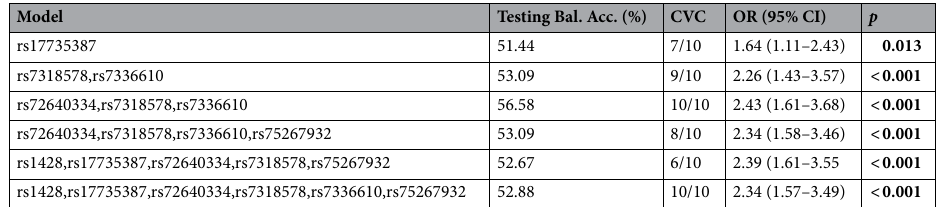
Table 5. SNP–SNP interaction models of MIR17HG gene the predisposition of HAPE. MDR multifactor dimensionality reduction, Bal. Acc. balanced accuracy, CVC cross-validation consistency. p values were calculated using χ 2 test. Bold indicated that p < 0.05 means the data is statistically significant.